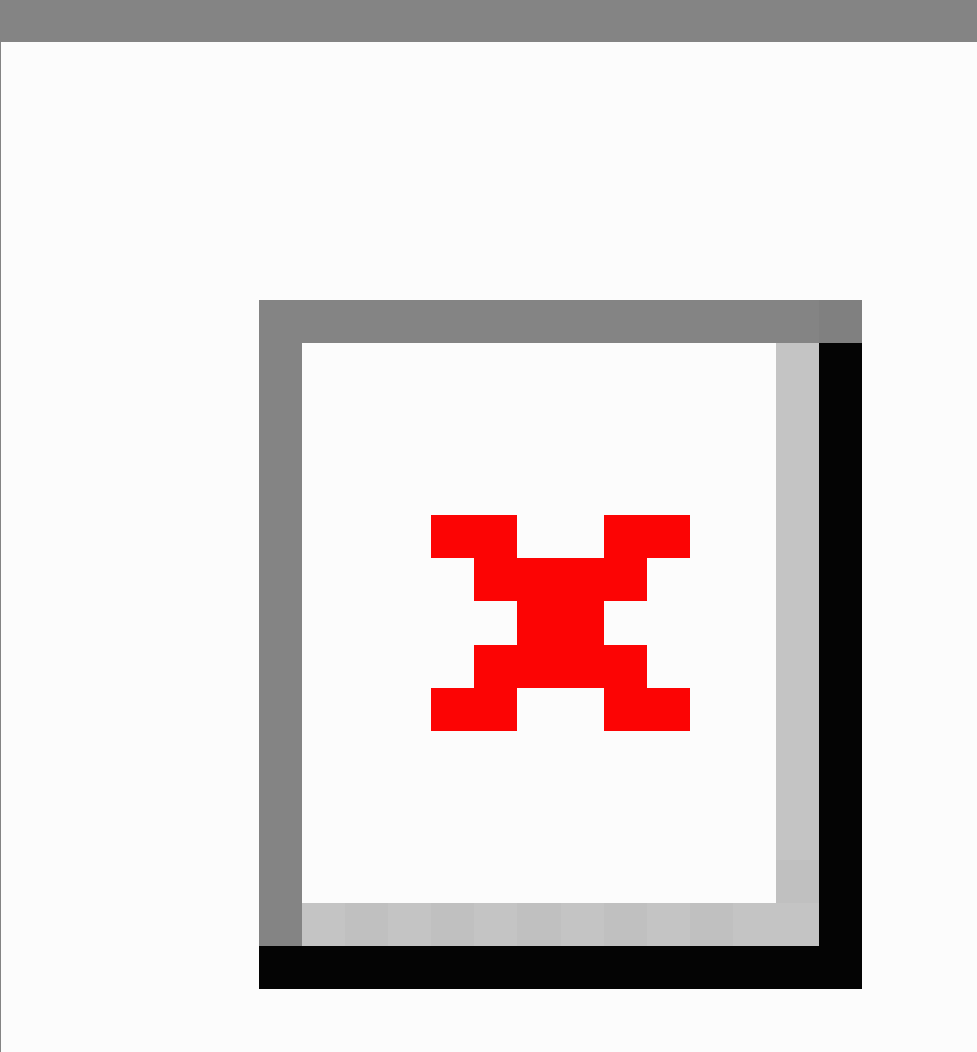
Figure 7. Topic evolution by year, with each category reported as a proportion of the total comments per